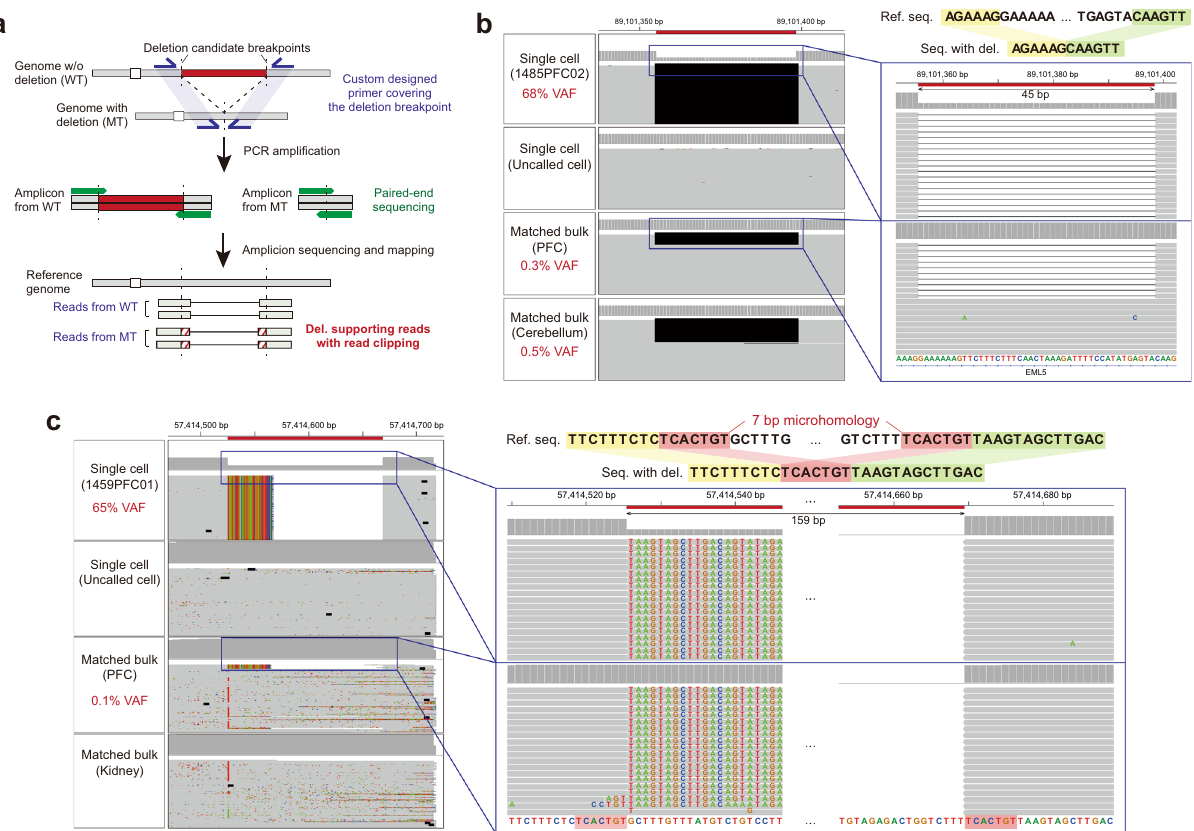
Fig. 2 | Validation of somatic deletions by ultra-deep amplicon sequencing. a Illustration of validation sequencing with custom amplicons targeting predicted deletion breakpoints. Box fi lled with red diagonal lines represents clipped part of the read. WT wild-type, MT mutant. b Example of a validated low-level mosaic deletion. An IGV screenshot shows reads supporting the breakpoints of a 45-bp deletion (black line) in amplicon sequencing datasets of MDA-ampli fi ed DNA from the same single-cell from which PhaseDel called the deletion (VAF 68%) and bulk